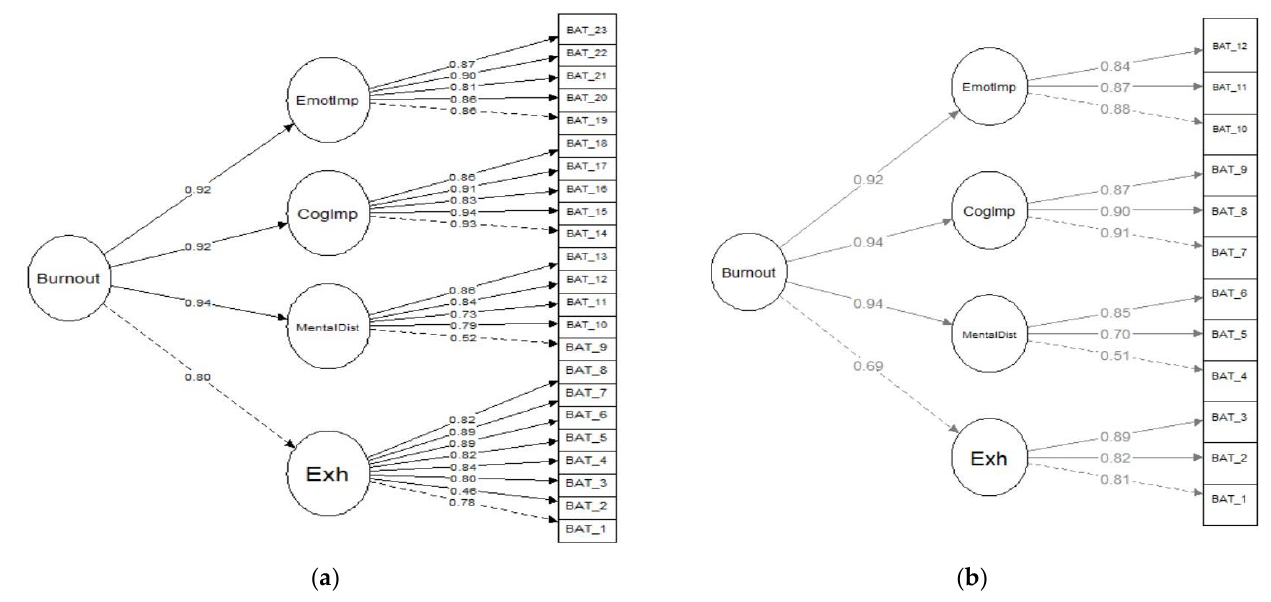
Figure 1. Burnout structural factor model for BAT-23 ( a ) and BAT-12 ( b ). Table 2. Standardized parameters of items of BAT-23 and